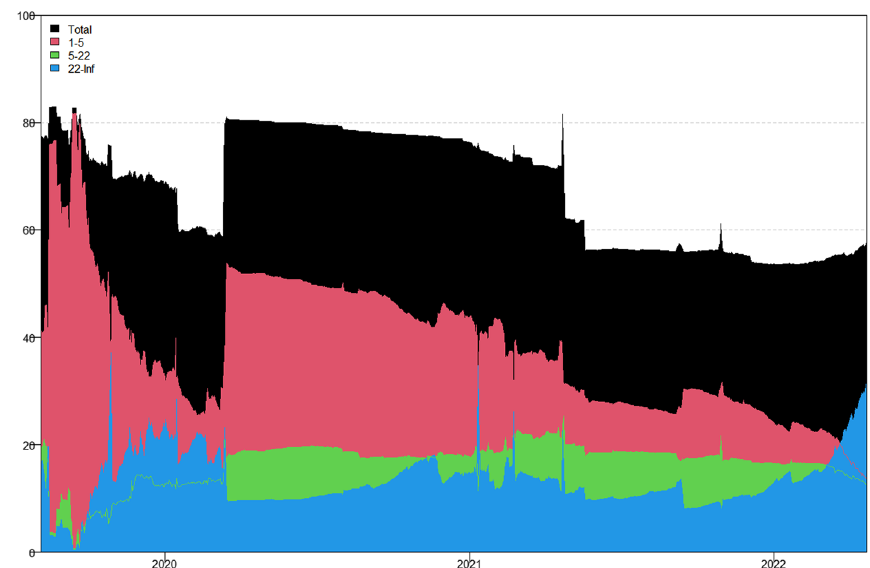
Fig. 32 Dynamic total RV connectedness—robustness check